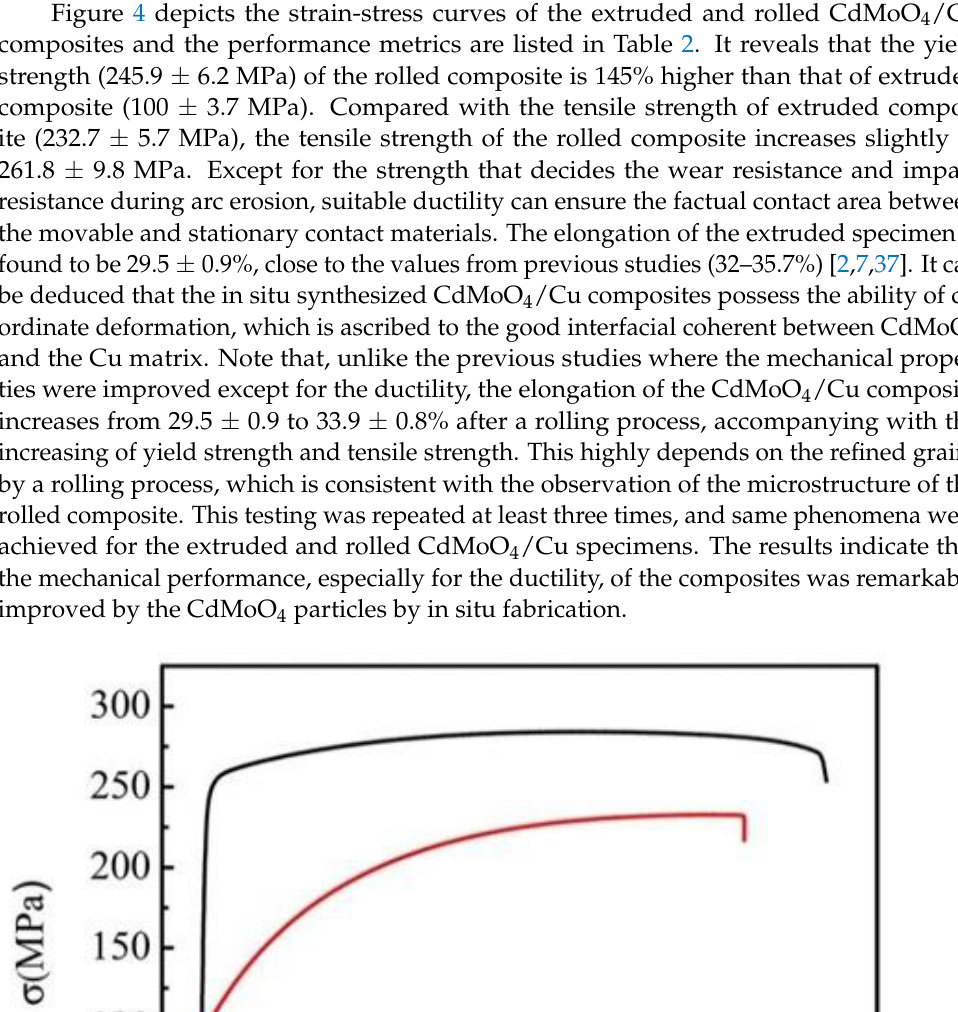
Table 2. Mechanical properties of CdMoO 4 -reinforced Cu-based composites.